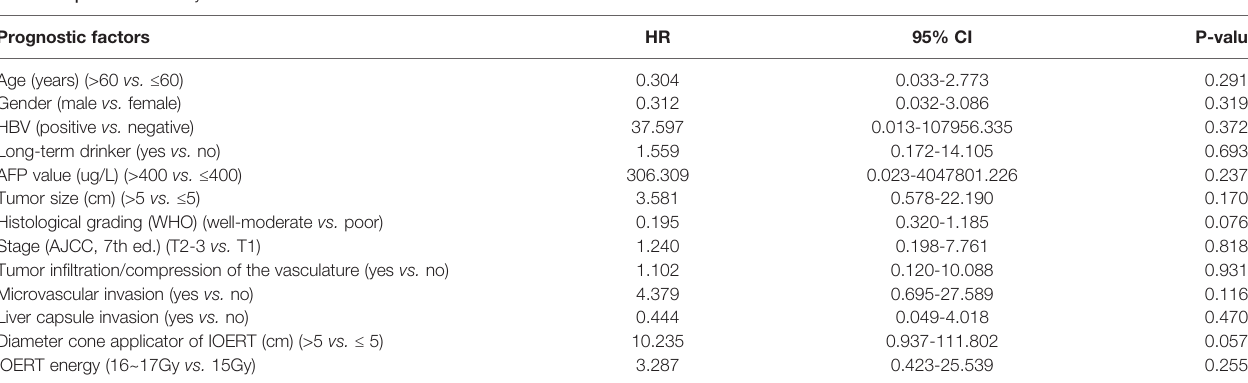
TABLE 2 | Univariate analysis for overall